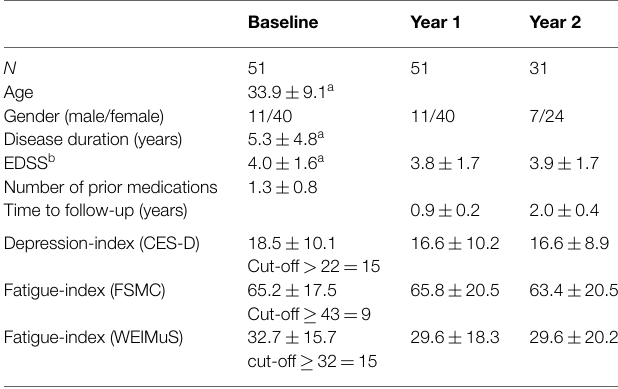
TABLE 1 | Description of the sample